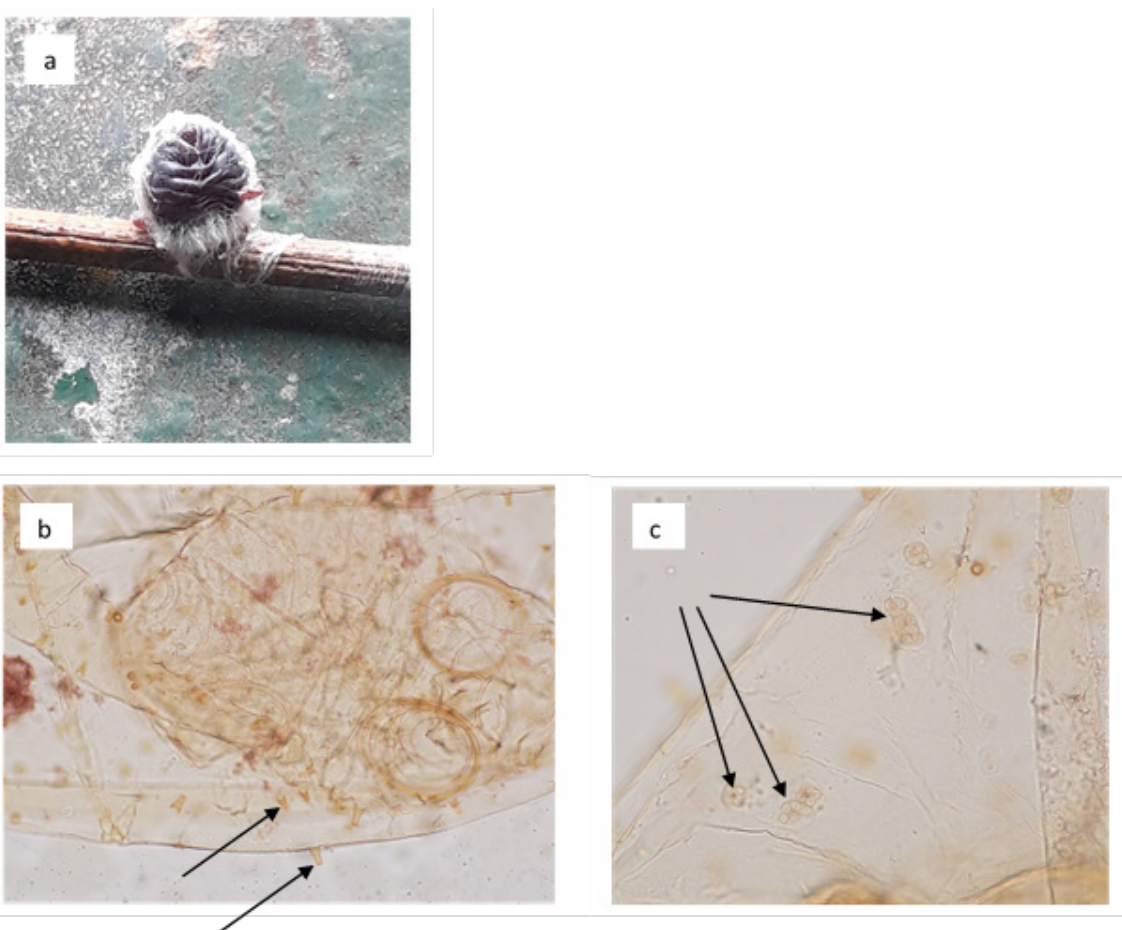
Figure 2: (a) Adult female (2.4 mm length) and slide mounted specimen of Dactylopius opuntiae showing (b) numerous short, cylindrical and moderately to strongly stout setae (10 × 100) and (c) narrow rimmed pores that are numerous on the ventral side of the last three abdominal segments (10 × 100 ×